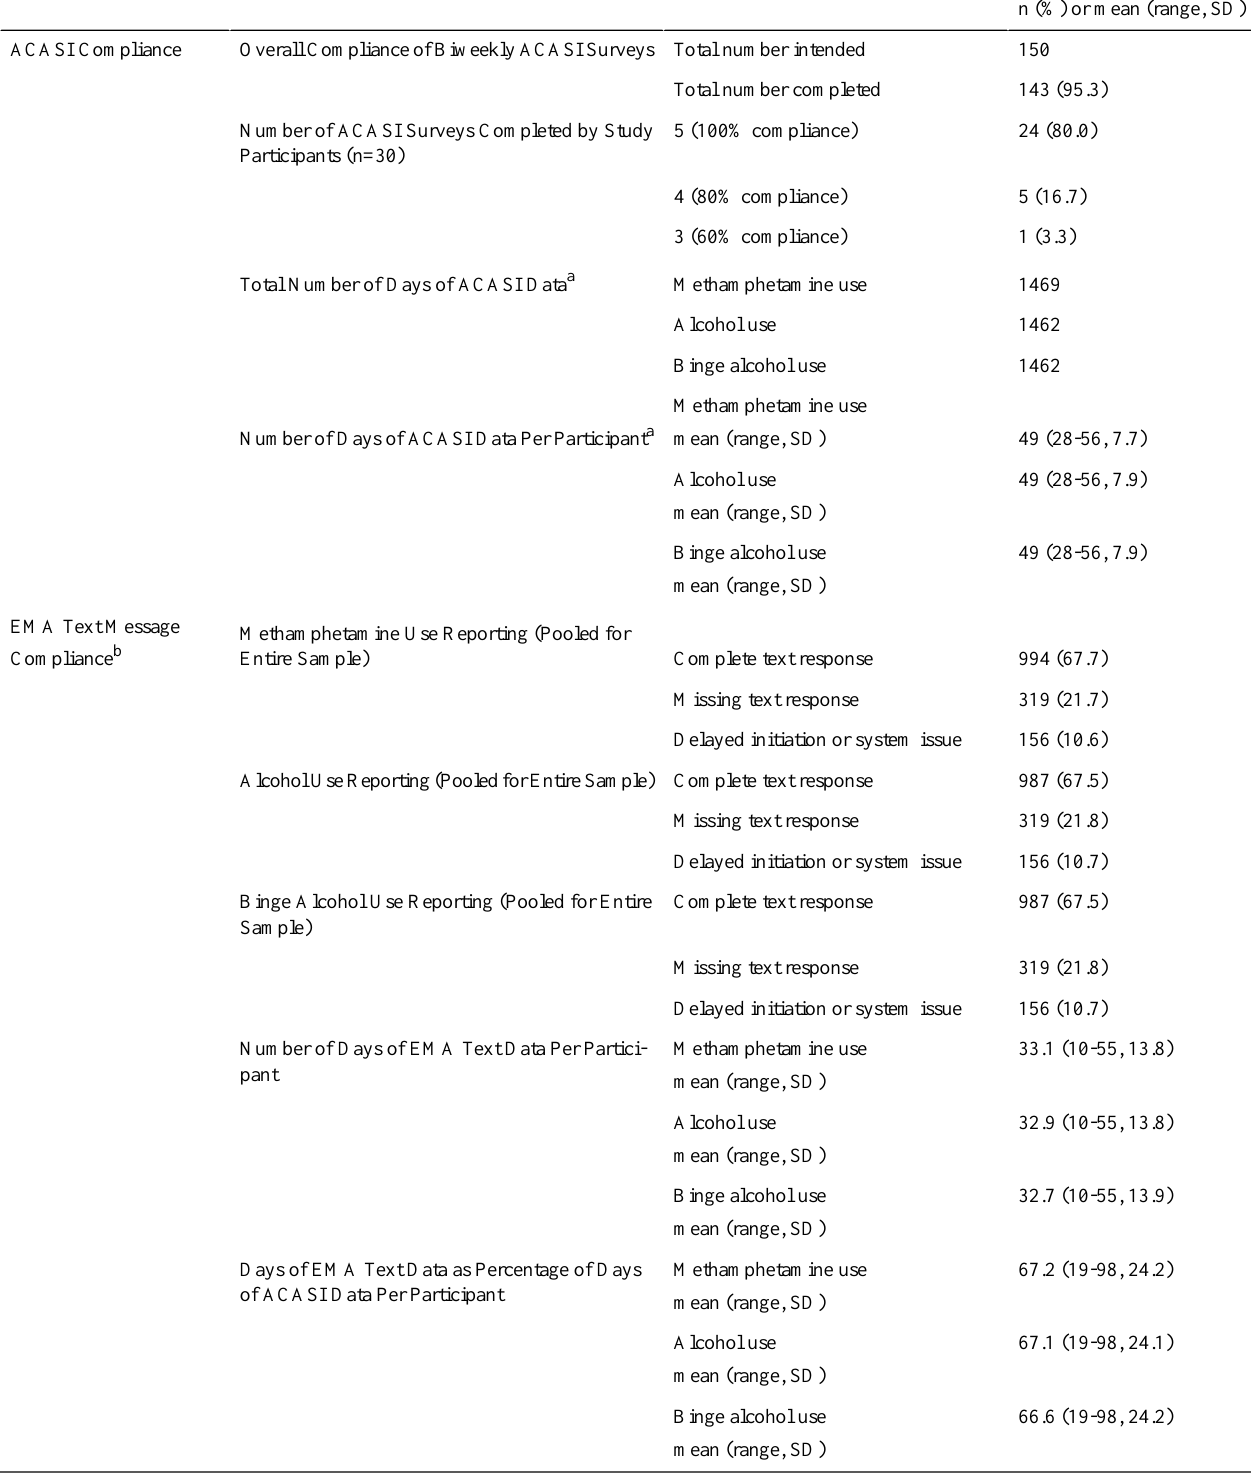
Table 2. ACASI and EMA text message reporting